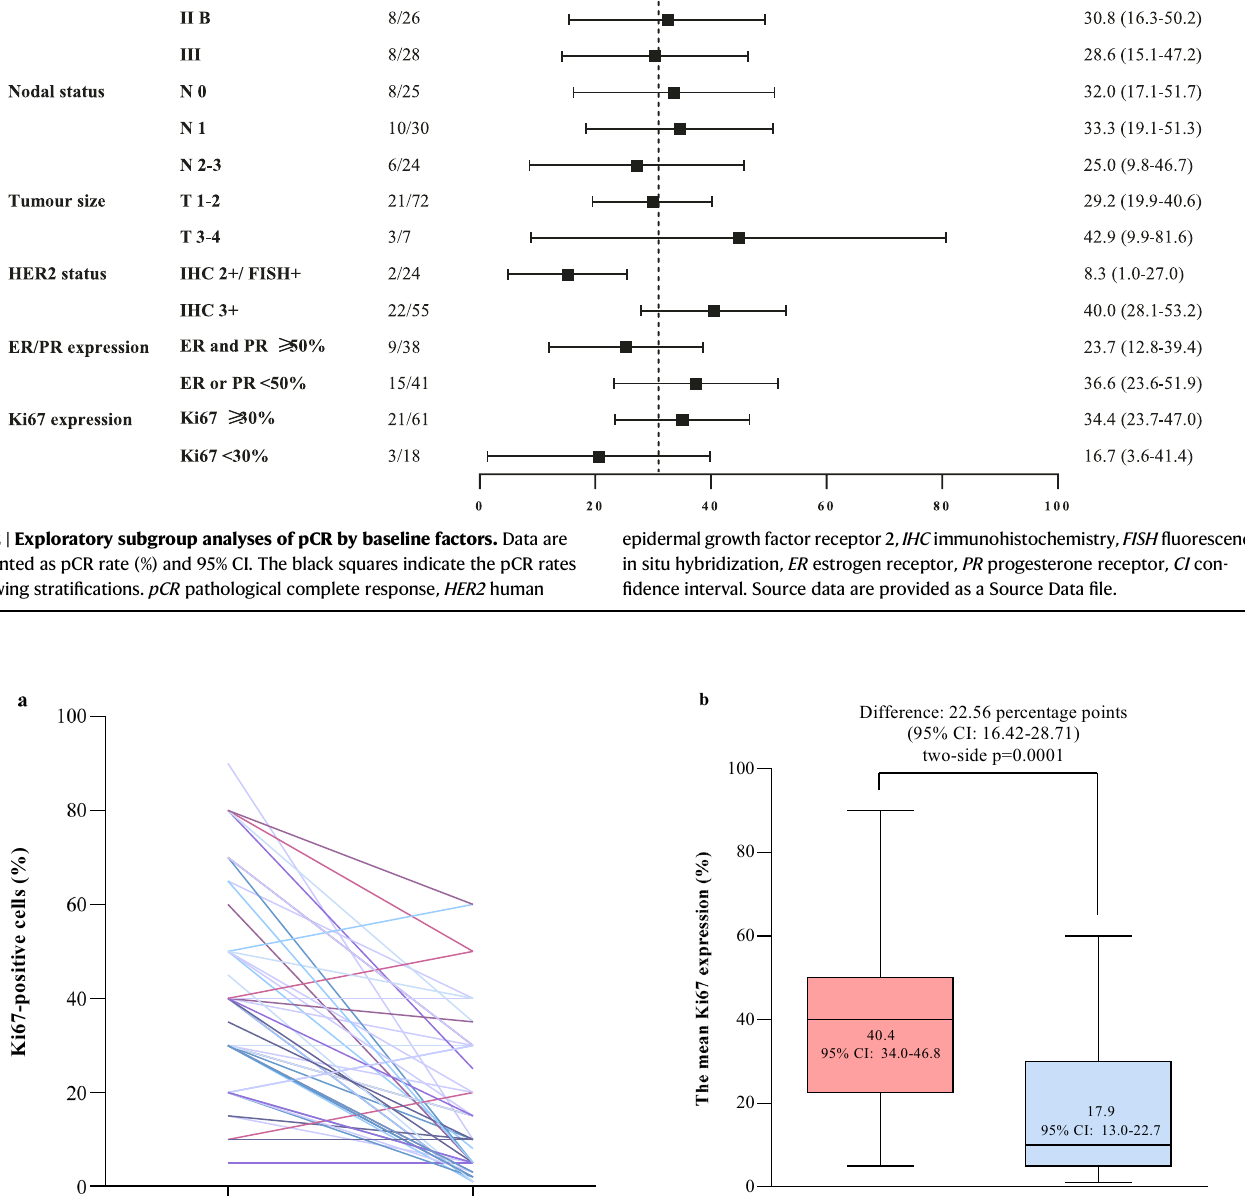
surgical samples ( n =30) or not undergoing surgery ( n =1). For box plots, the centerlinesaregroupmedians;theupperandlowerlimitsoftheboxarethe1stand 3rd quartile, and the whiskers show minimum and maximum values. CI con fi dence interval. Source data are provided as a Source Data fi